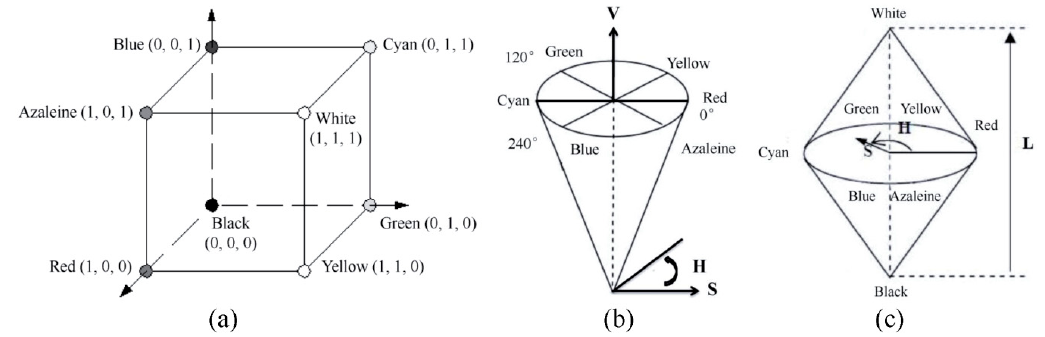
Figure 1. ( a ) RGB color space; ( b ) HSV color space; and ( c ) HLS color space.